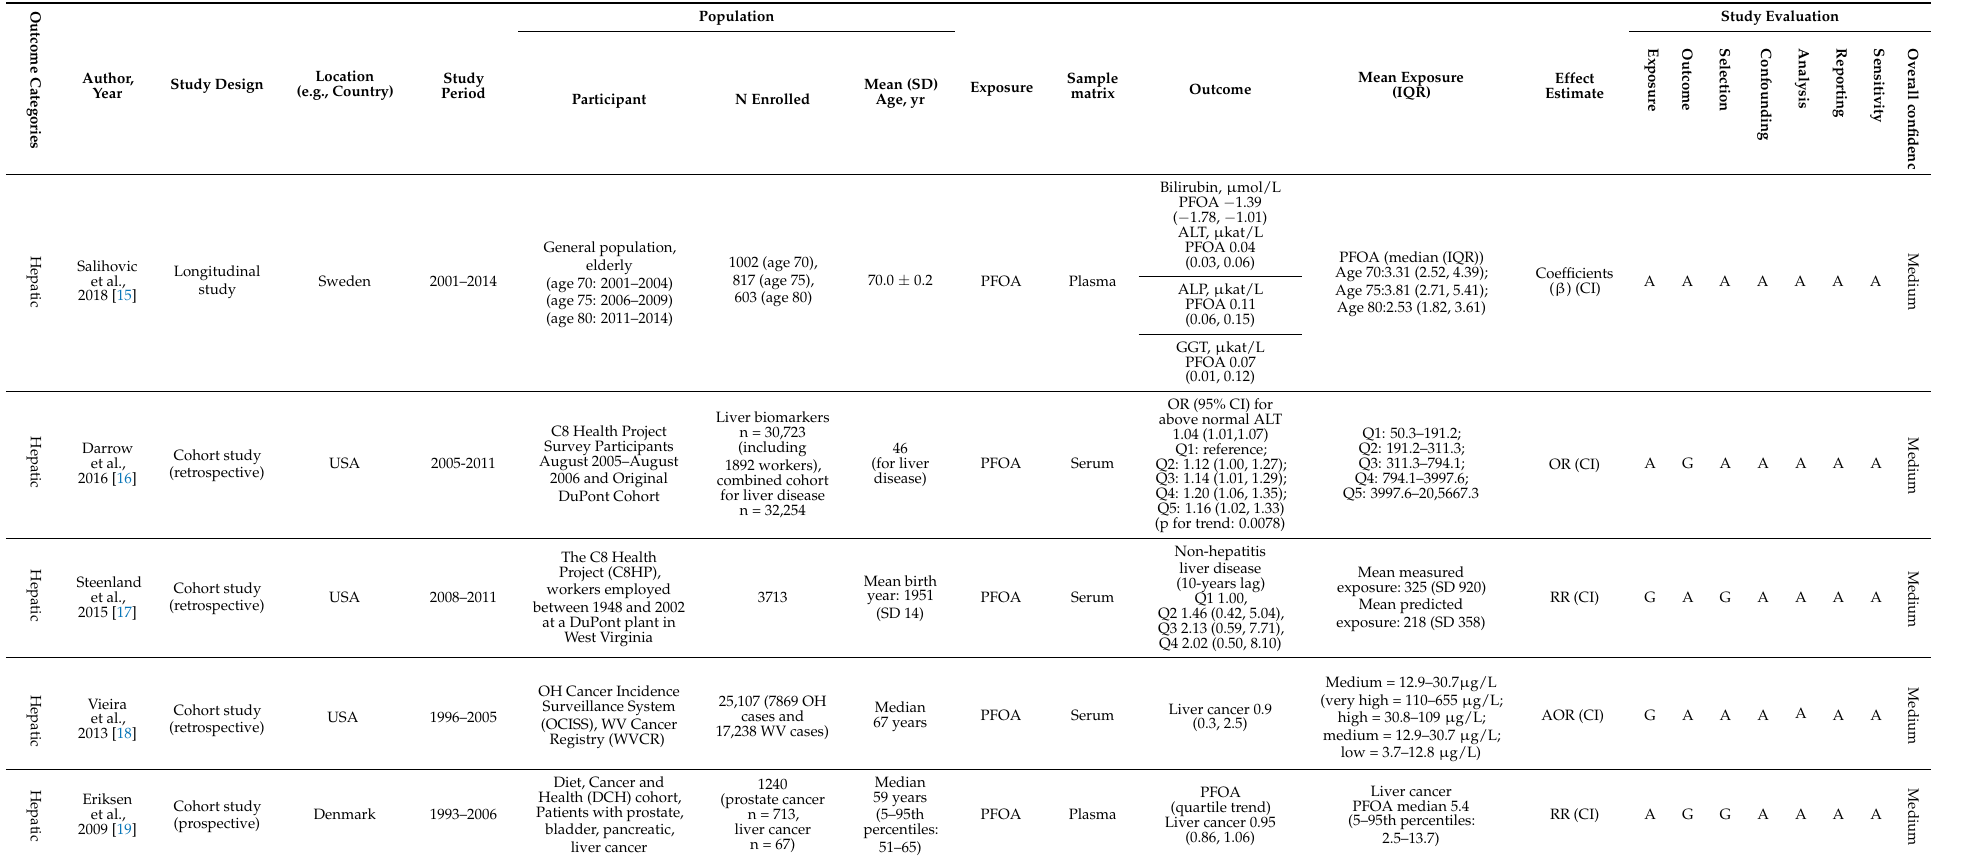
Table 1. Characteristics and risk of bias assessment of the epidemiology